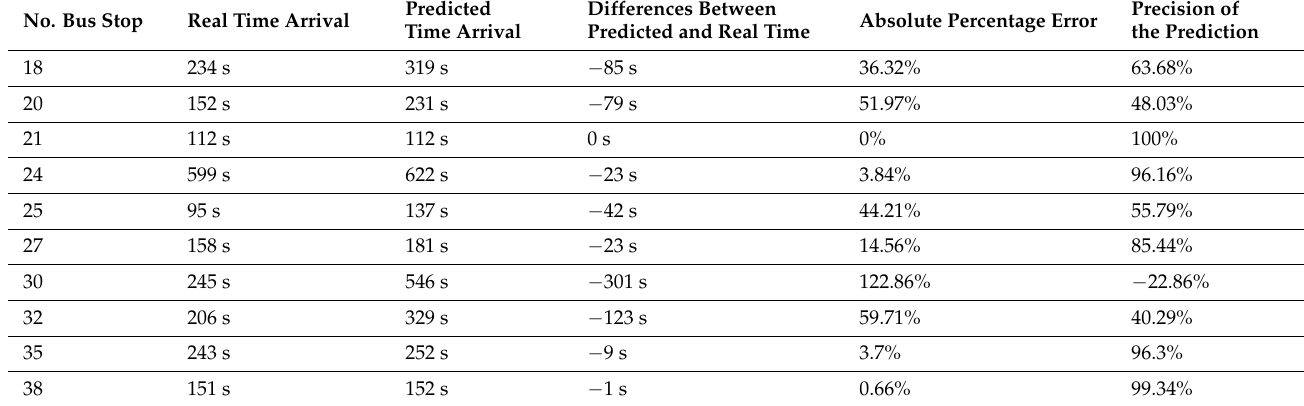
Table 8. Results obtained for Trip 8, Journey: University–Guacamayas. MAPE = 33.8% Precision = 66.2%.